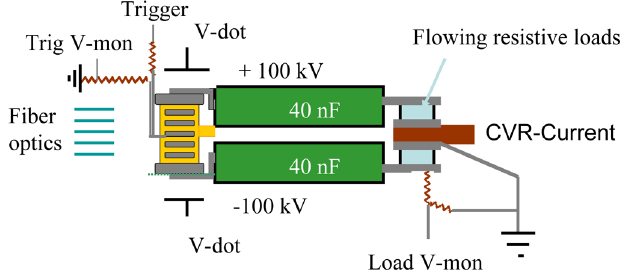
FIG. 3. (Color) Russian switch designed by the High Current Electronics Institute attached to capacitors in our LTD brick. FIG. 4. (Color) Schematic of our LTD brick and